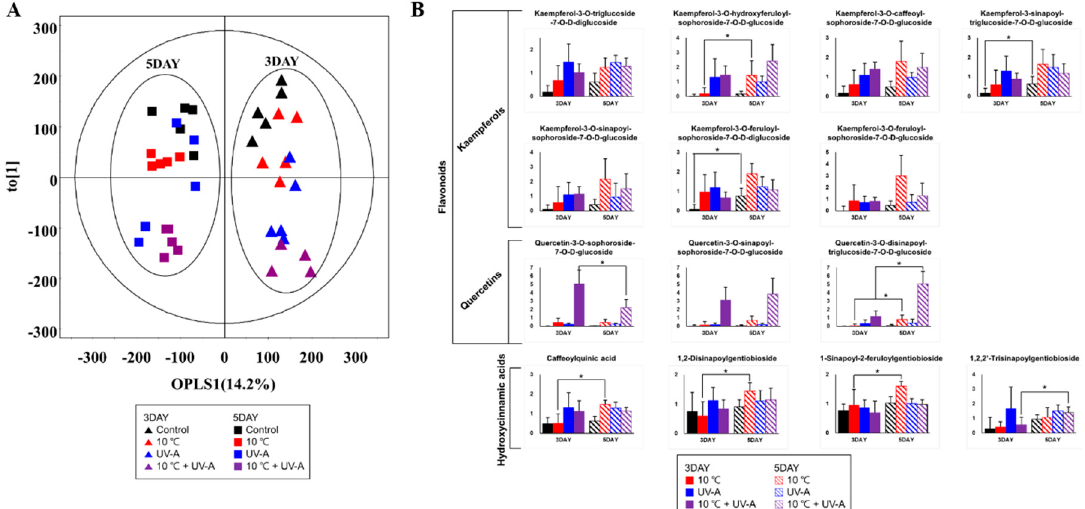
Figure 6. OPLS–DA score plots based on UPLC–Q–TOF–MS data from day 3 (after 3 days of stress treatment) versus day 5 (after 2 days of recovery) ( A ). Bar graphs of the relative levels of secondary metabolites (variable importance in projection (VIP) > 0.7) on days 3 and 5 ( B ). Solid bars—day 3, striped bars—day 5, black bars—control, red bars—10 °C, blue bars—UV ‐ A, purple bars—combined treatment. Asterisks indicate significant differences ( p ‐ value < 0.05) between days 3 and 5.